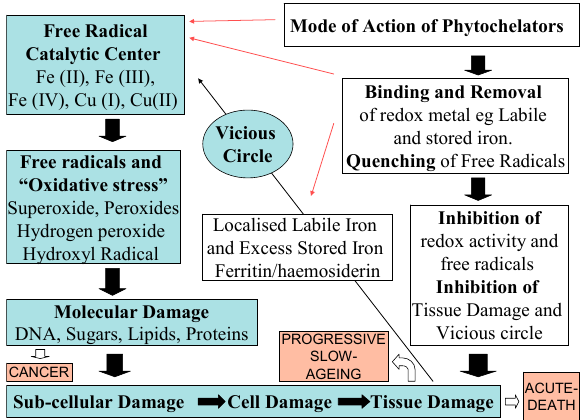
Figure 2. The role of phytochelators in inhibiting free radical formation and damage. Vicious circle of free radical toxicity catalysed by iron and copper catalytic centres leading to oxidative stress and molecular, subcellular, cellular and tissue damage and associated diseases such as cancer, acute iron toxicity and ageing.